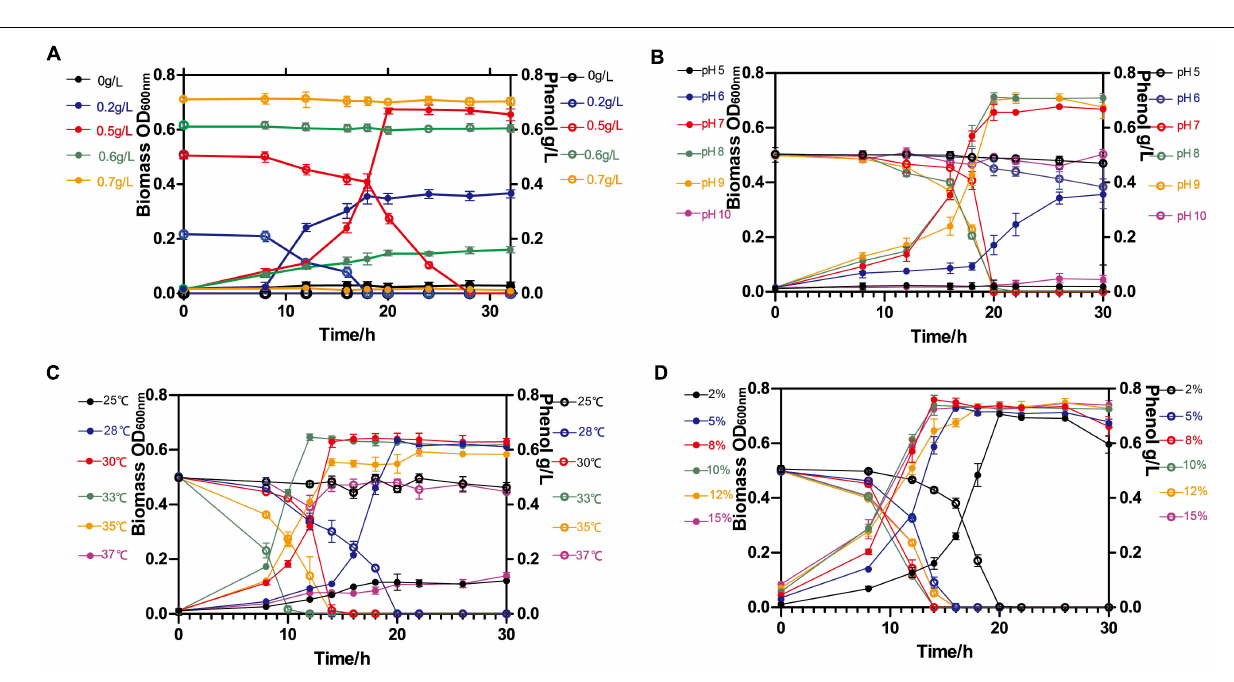
FIGURE 5 | Phenol degradation and cell growth of A. lwoffii NL1. (A) A. lwoffii NL1 growth at different initial phenol concentrations. Effects of initial pH (B) , culture temperature (C) , and inoculum volume (D) on bacterial growth and phenol degradation. Filled circle, biomass OD; hollow circle, phenol concentration. Different conditions were represented by contrasting colors along the ordinate